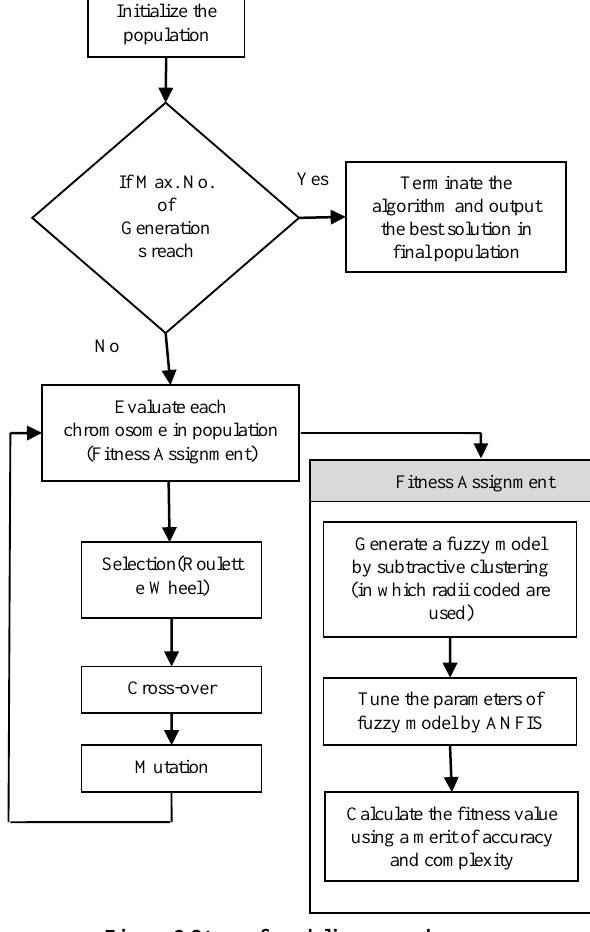
Figure 2.Steps of modeling